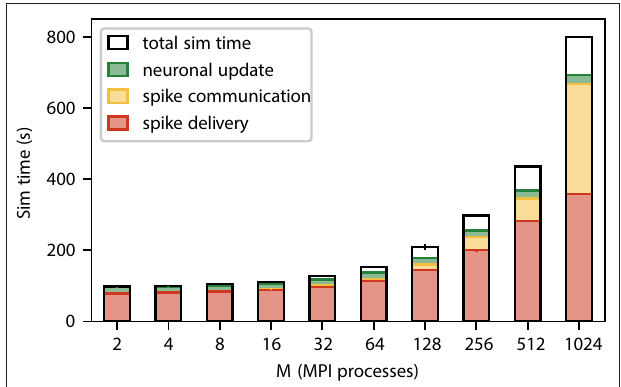
FIGURE 3 | Contributions to the simulation time (sim time) for spiking neural network simulations with NEST (Section 3.1) where the number of MPI processes increases proportionally with the total number of neurons. Weak-scaling experiment running 2 MPI processes per compute node and 12 threads per MPI process, with a workload of 125,000 neurons per MPI process (network model see Section 3.2). The network dynamics is simulated for 1 s of biological time; spikes are communicated across MPI processes every 1.5 ms. Time is spent on spike delivery (red bars), communication of spike data (yellow bars), neuronal update (green bars), and total sim time (black outline). Error bars (for most numbers of MPI processes hardly visible) indicate the SD over three repetitions. Timings obtained via manual instrumentation of the respective parts of the source code, measured on JURECA CM (Section